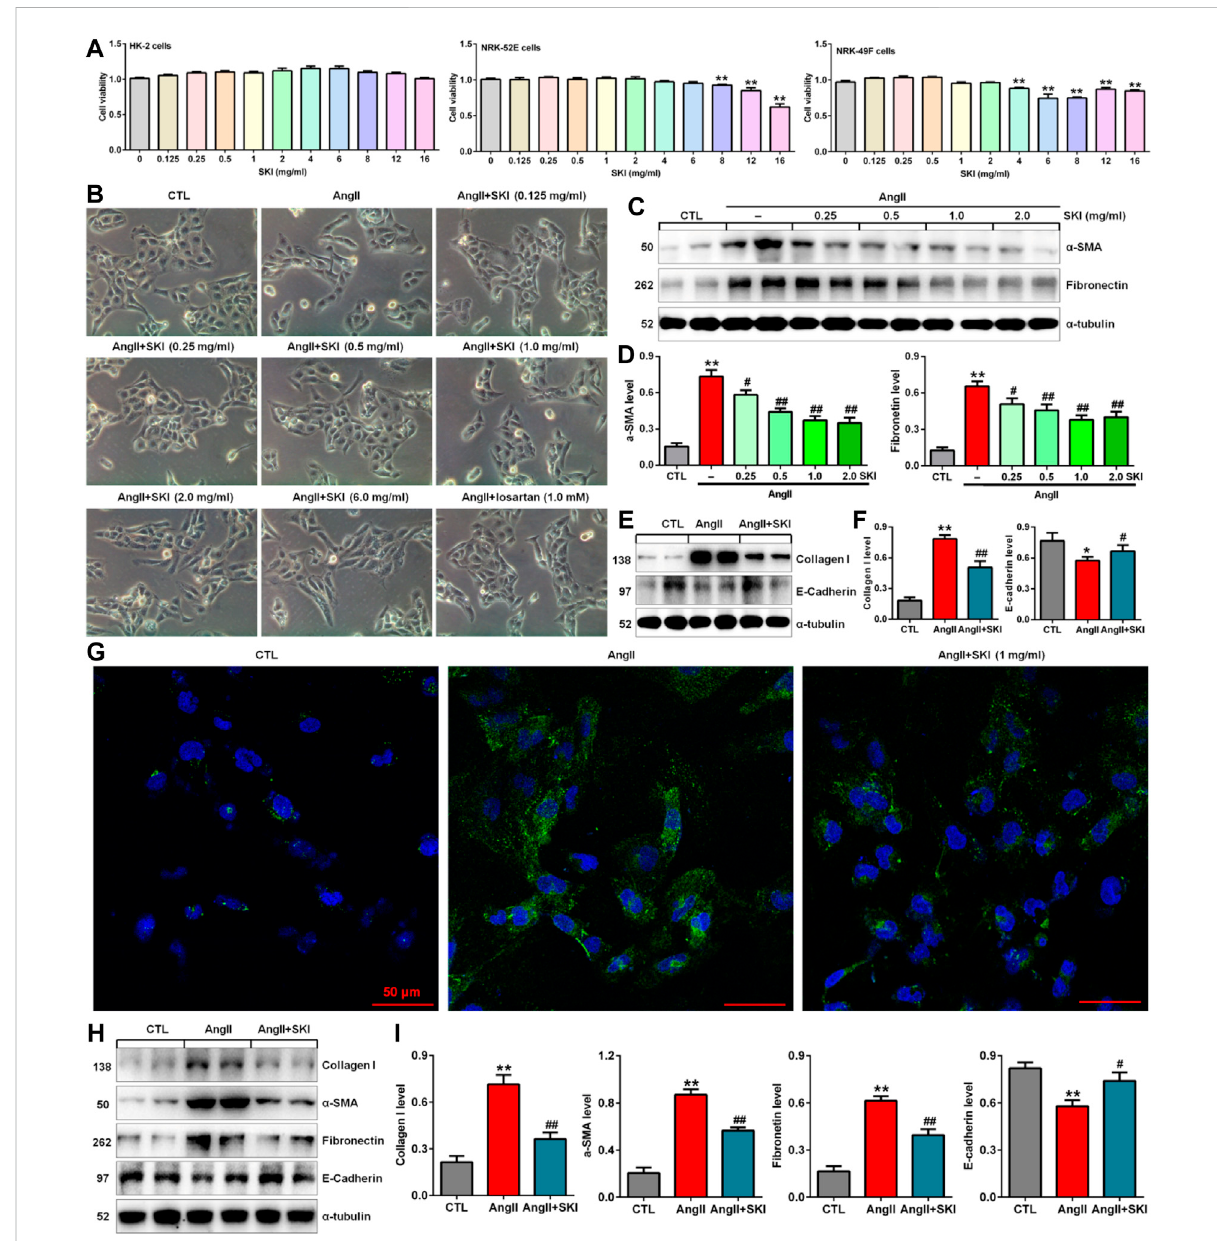
FIGURE 4 SKI improved morphological changes and injury in AngII-induced HK-2 cells. (A) Cell viability analysis after HK-2, NRK-52E and NRK-49F cells were treated with increasing concentrations of SKI (0 – 16 mg/ml). (B) Morphological observation in AngII-induced HK-2 cells treated with different concentrations of SKI (0 – 6.0 mg/ml) and losartan (1.0 mM) at 48 h. (C) Protein expression of α -SMA and fi bronectin in AngII-induced HK-2 cells treated with different concentrations of SKI (0.25, 0.5, 1.0, 2.0 mg/ml). (D) Quantitative analysis of the protein expression of α -SMA and fi bronectin in AngII-induced HK-2 cells treated with different concentrations of SKI (0.25, 0.5, 1.0, 2.0 mg/ml) for 48 h. (E) Protein expression of collagenIandE-cadherininAngII-inducedHK-2cellstreatedwithSKI. (F) QuantitativeanalysisoftheproteinexpressionofcollagenIandE-cadherin in AngII-induced HK-2 cells treated with SKI. (G) Representative immuno fl uorescent analysis of fi bronectin in AngII-induced HK-2 cells treated with SKI. (H) Protein expressionof collagen I, α -SMA, E-cadherin and fi bronectin inAngII-induced NRK-49F cells treated with SKI. (I) Quantitative analysis of the protein expression of collagen I, α -SMA, E-cadherin and fi bronectin in AngII-induced NRK-49F cells treated with SKI. * p < 0.05, ** p < 0.01 compared with the control group; # p < 0.05, ## p < 0.01 compared with the AngII-induced